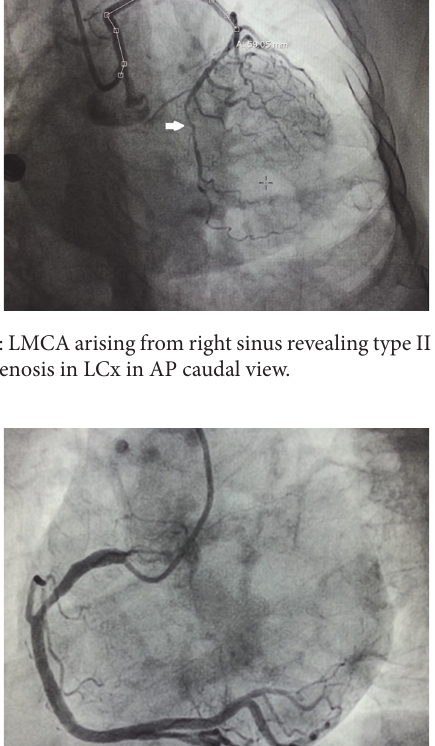
Figure 2: LMCA arising from right sinus revealing type II LAD and critical stenosis in LCx in AP caudal view.